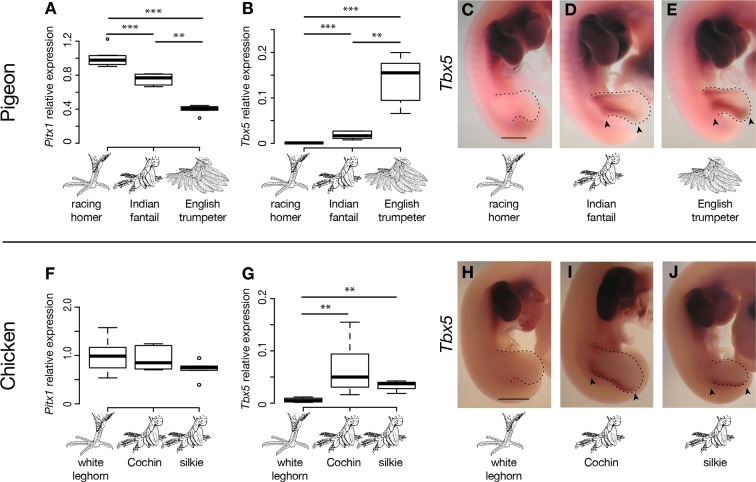
Limb-type gene expression varies among feathered and scaled pigeons and chickens.(A,B,F,G) qRT-PCR analyses of Pitx1 and Tbx5 expression in HH25 hindlimbs of pigeon (A,B) and chicken (F,G). Boxes span 1st to 3rd quartiles, bars extend to minimum and maximum observed values if within 1.5 times the interquartile range of the box, circles indicate values outside of this range, black line indicates median. **=p<0.01, ***=p<0.001. (C-E, H-J) RNA in situ hybridization for Tbx5 expression in HH25 embryos of racing homer (C), Indian fantail (D), and English trumpeter (E) pigeons; and white leghorn (H), Cochin (I), and silkie (J) chickens. Arrowheads indicate sites of ectopic Tbx5 expression. Scale bar = 1 mm.DOI:
http://dx.doi.org/10.7554/eLife.12115.01110.7554/eLife.12115.012Figure 3—source data 1.Source data from quantitative RT-PCR experiments.Abbreviations: fl, embryonic forelimb; hl, embryonic hindlimb.